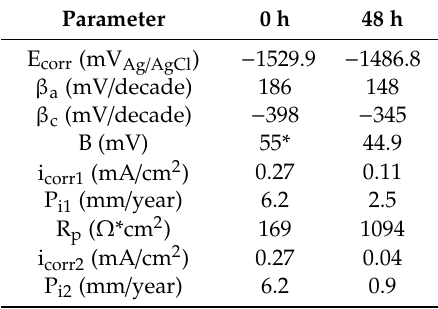
Figure 10. Linear polarization control in DC of EZ51-IM350 alloy immersed in PBS: ( a ) corrosion potential and ( b ) global resistance R p + R Ω and calculated i corr taking B = 45 mV. Table 2. Parameters measured (E corr , R p ) and calculated ( β , B, graphical i corr1 and corrosion rate ( P i1 ) from the linear polarization curves of Figure 9 for EZ51-IM350 alloy. R p value from EIS experiments and B = 45 mV were taken for the calculation of i corr2 and P i2 .